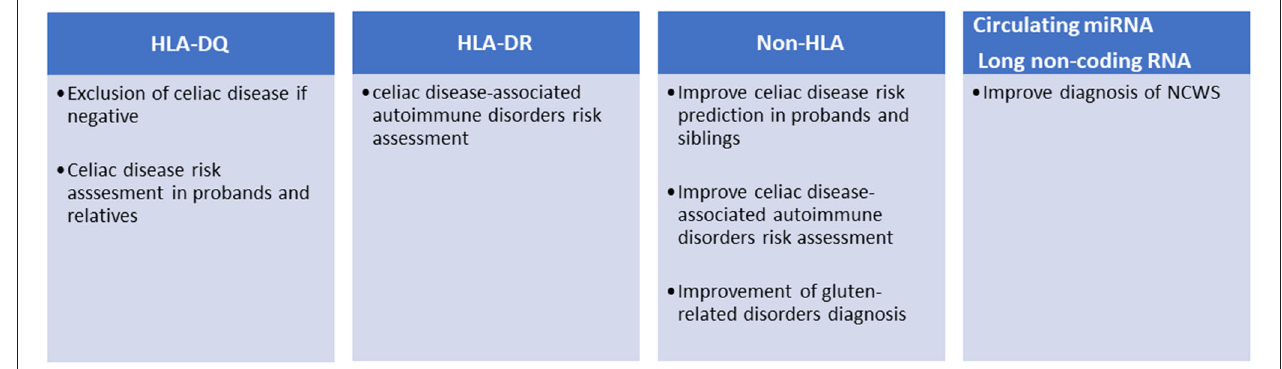
FIGURE 1 | Current and potential clinical applications of genetic markers in gluten-related disorders.